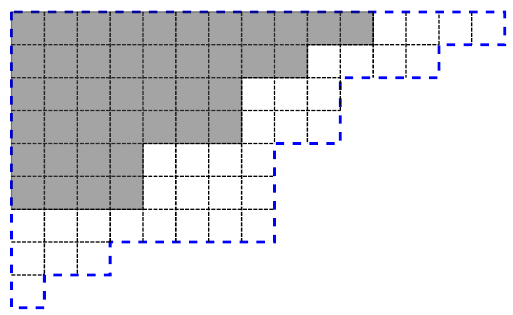
Figure 4 . The reduced Young diagram ¯ ν is denoted by the dotted exterior and the shaded region denotes the Young diagram µ